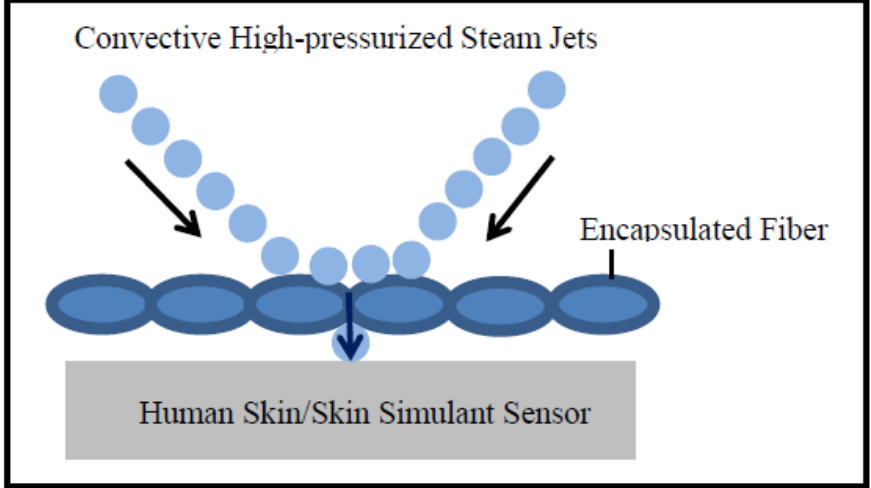
Figure 12. High-pressurized steam transfer through a single-layered encapsulated fiber finished fabric.